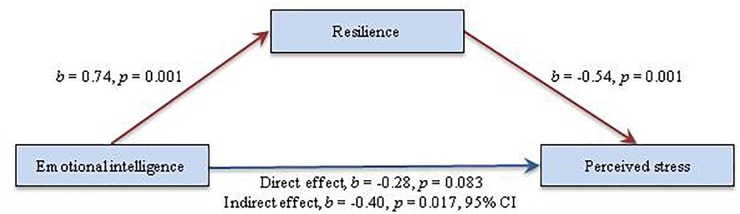
Standardized Solution of the Final Model in the Basque Sample.